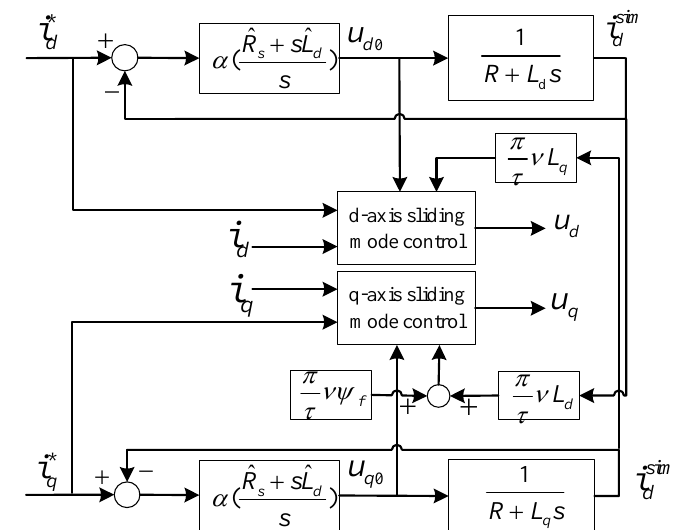
Figure 6. Optimized IMC-SM control based on decoupled current.